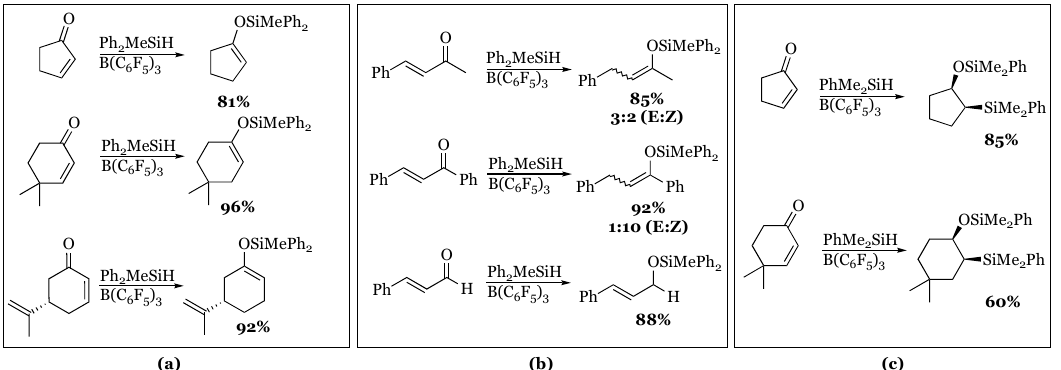
Figure 18. α,β -Unsaturated ketone reactivity: ( a ) Reduction of cyclic enones; ( b ) reduction of acyclic enones and cinnamaldehyde; ( c ) iterative stereoselective silylation of enones.